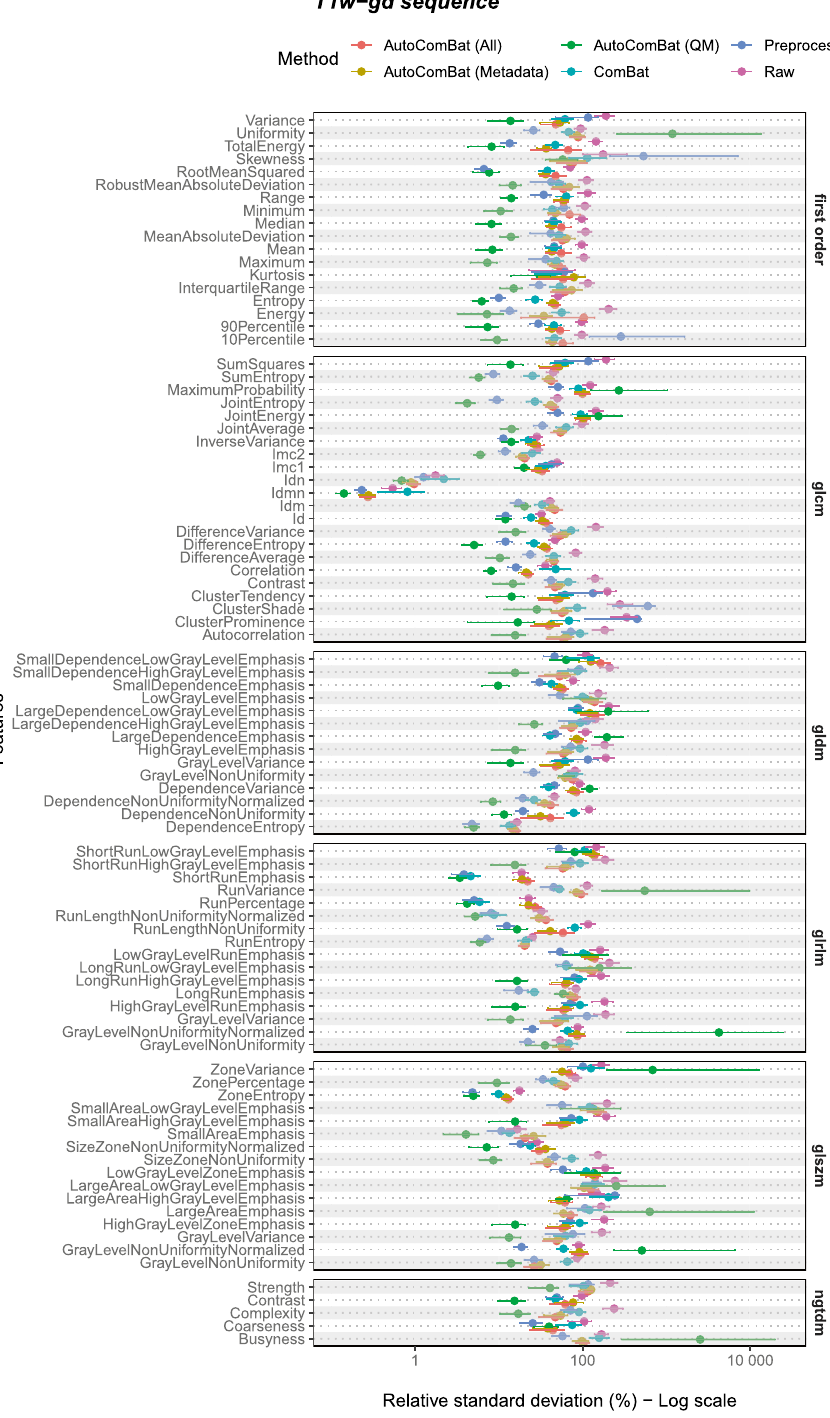
Figure 4. Harmonization strength evaluated on the WM radiomic features for the T1w-gd MRI on the test set. Points represent the RSD values and error bars are the 95%